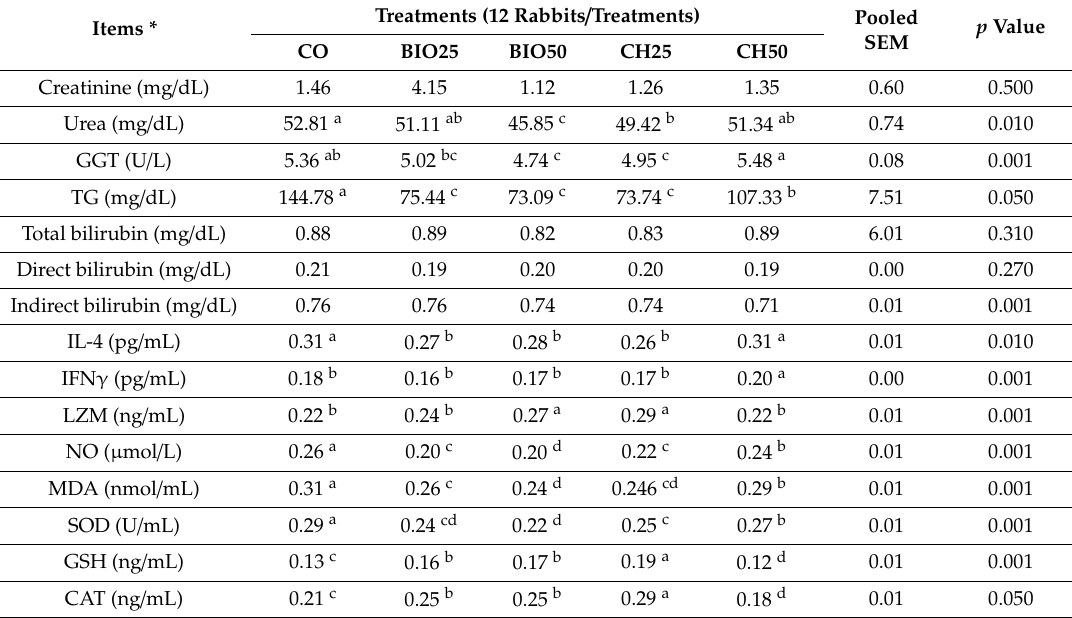
Table 5. Blood serum metabolites inflammatory and antioxidant indicators of NZW rabbits fed diets supplemented with biological or chemical selenium nanoparticles during heat stress. Items